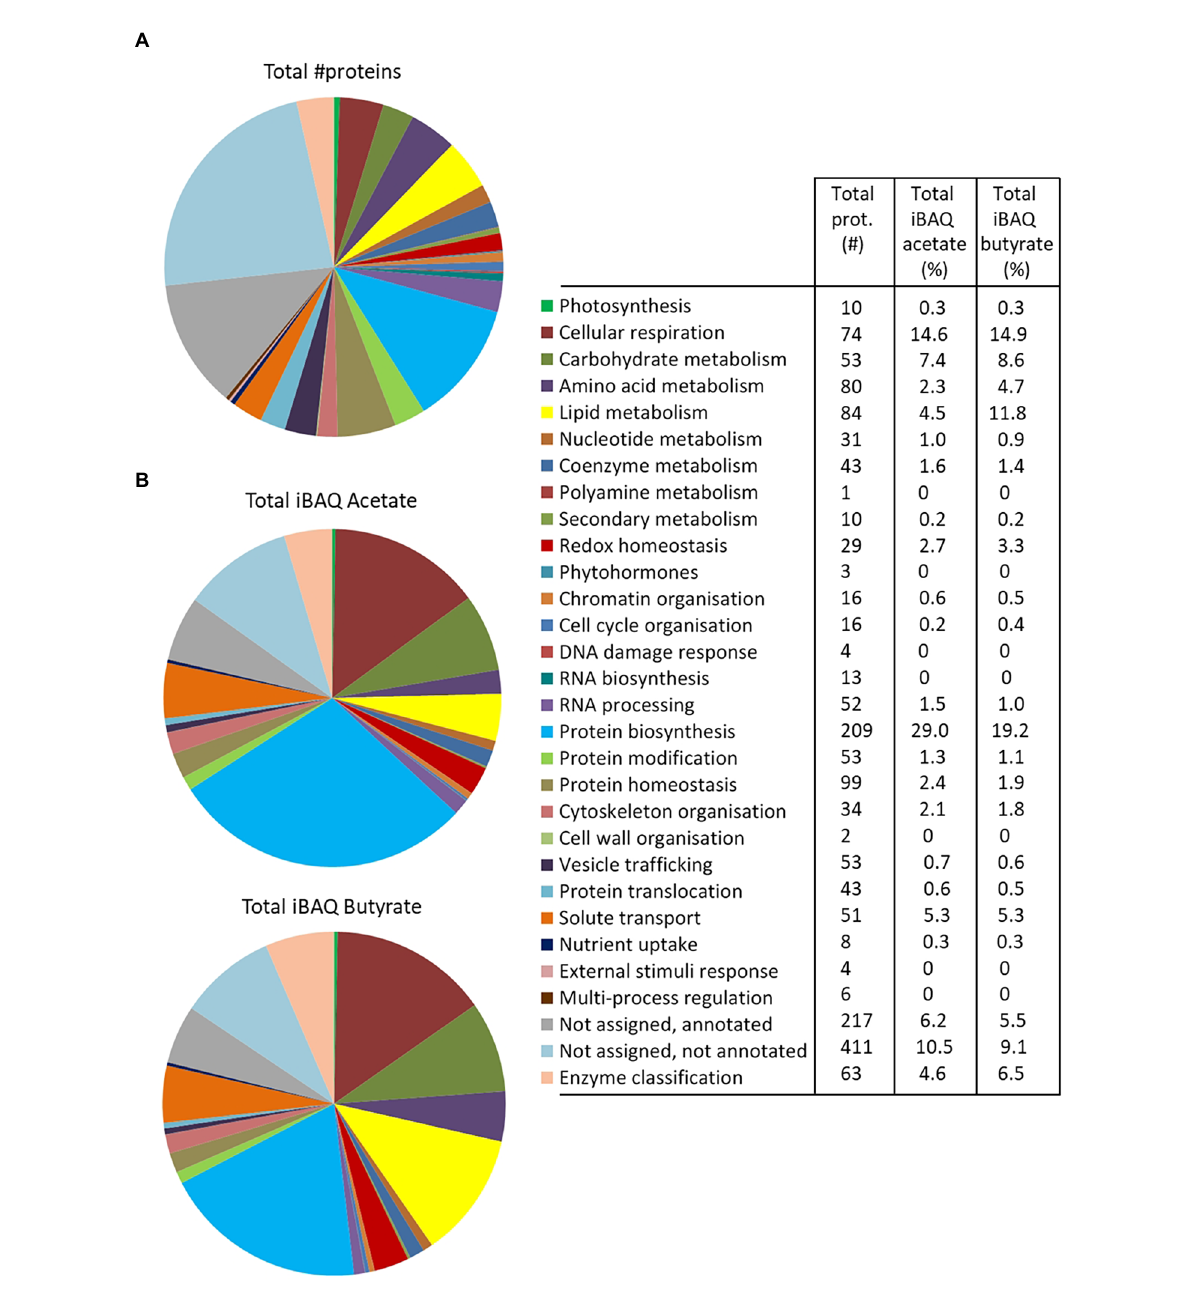
(Figure 5). The enzymes of the latter two functional groups are predicted to localize mostly to the peroxisomes, based on peroxisomal targeting prediction via software algorithms, manual analysis of the presence of peroxisomal targeting sequences PST1 and PST2, and/or the relatedness to peroxisomal enzymes in the green alga C. reinhardtii (Table 1; see also Supplementary Table 1). Peroxisomes, organelles primarily